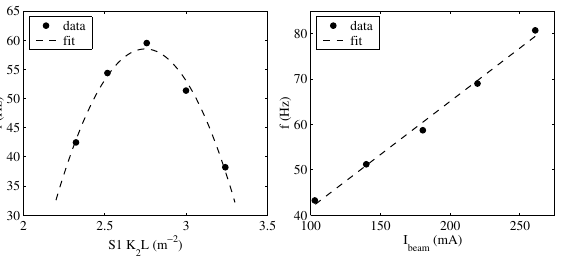
FIG. 5. Low frequencies associated with transverse instabil- ities as functions of the harmonic sextupole strength (left panel) and of beam current (right panel) for a fixed strength L (cid:1) 2 : 75 m (cid:6) 2 ). of the sextupole ( K 2